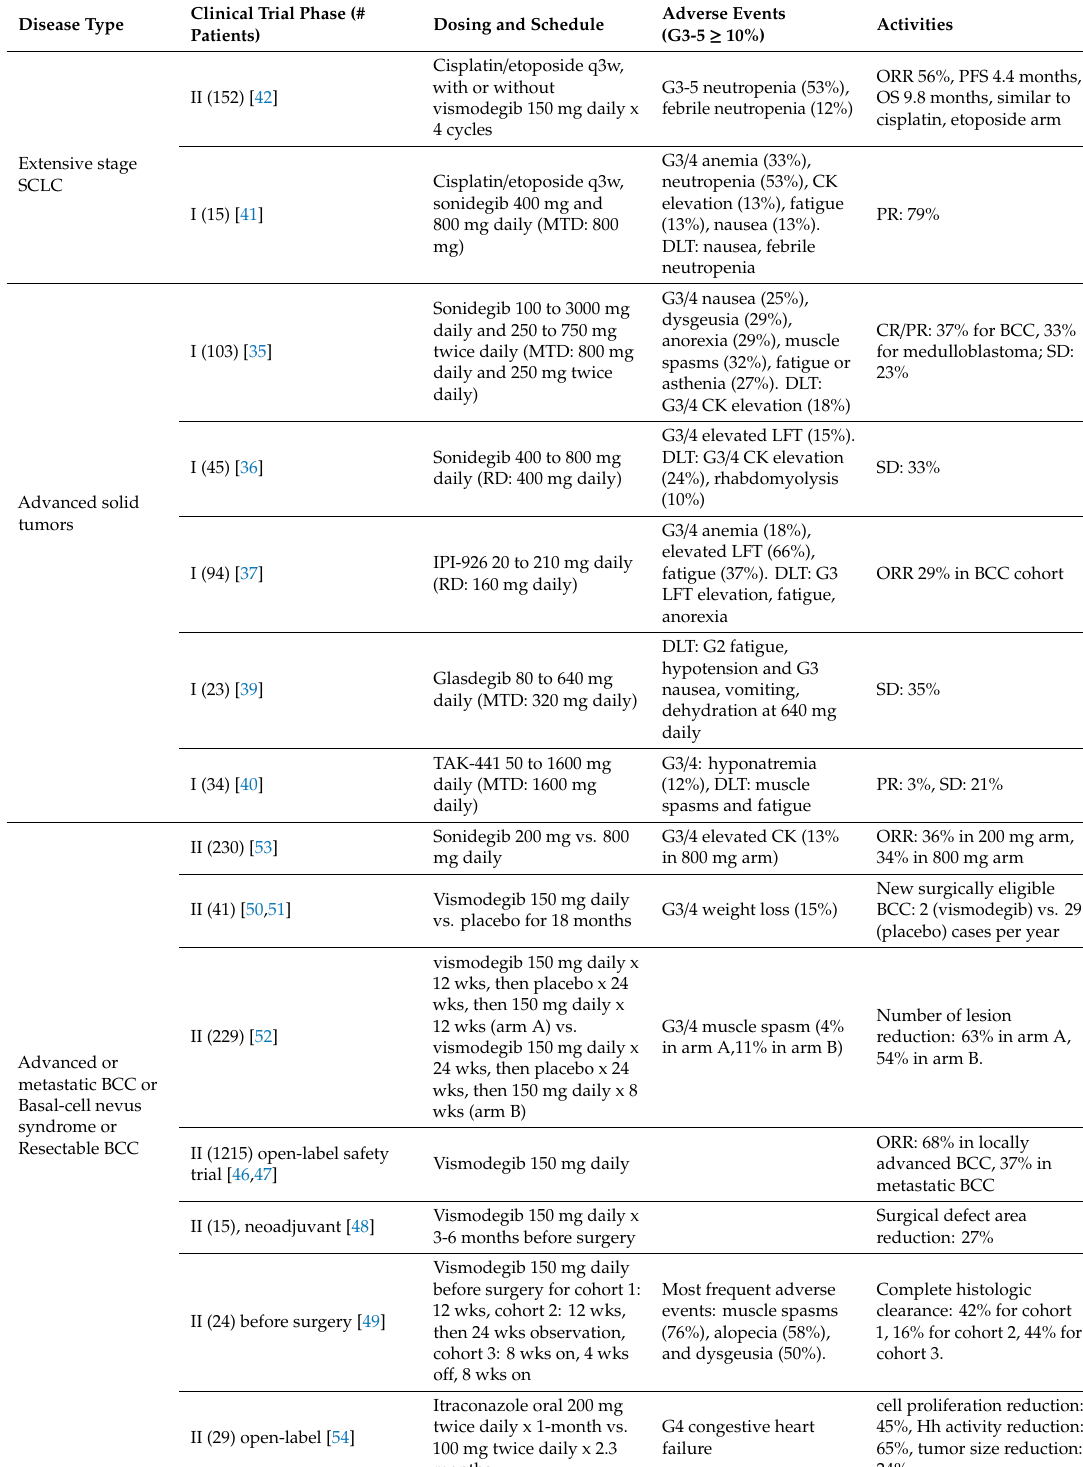
Table 1. Published clinical data with hedgehog signaling pathway inhibitors in the past five years. Disease